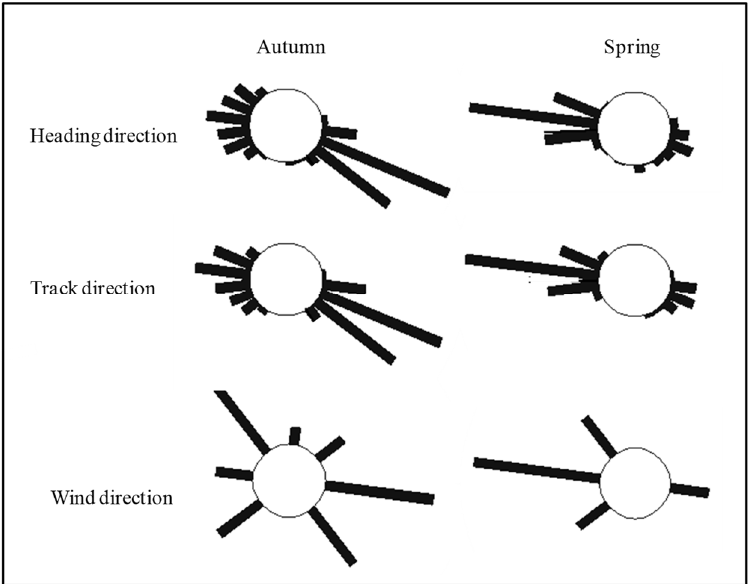
Figure 2. Total distribution of heading, track, and wind directions, both in spring and autumn migrations. All distributions are bimodal, with peaks in easterly and westerly sectors. Wind direction is the direction the wind is coming from, while flight direction (track and heading) is the direction toward which the bird is moving.